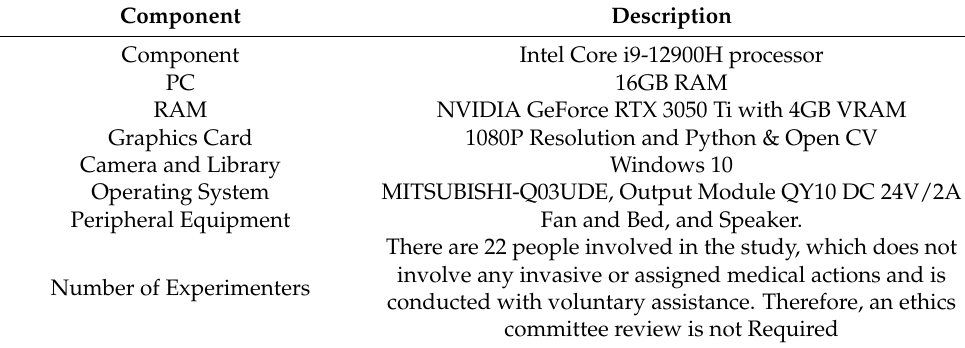
Table 3. Equipment and development